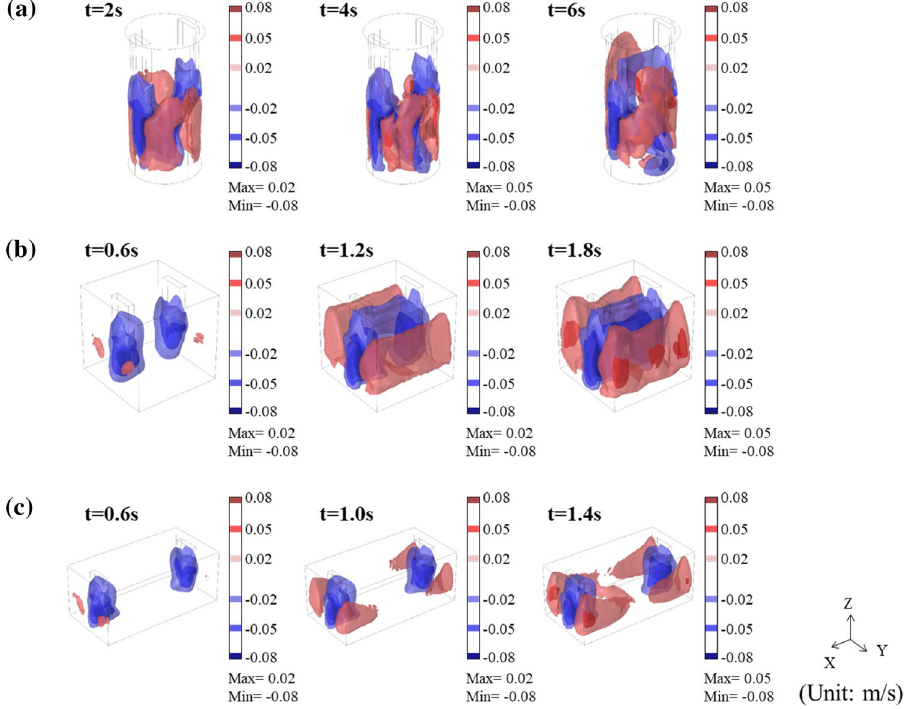
Figure 6. 3D velocity map for ( a ) the cylinder-, ( b ) cube-, and ( c ) cuboid-shaped cavities from the numerical